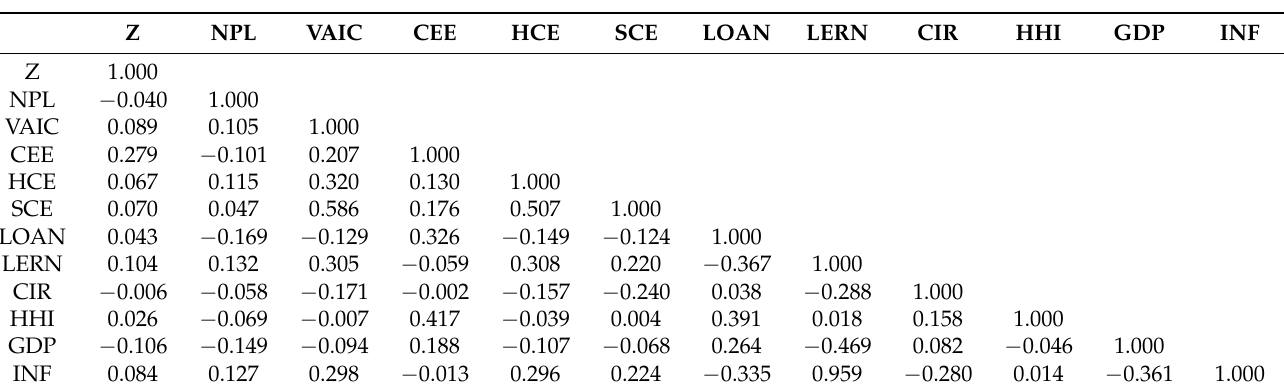
Figure 1. Histogram for Z and NPL . Table 2. Correlation matrix.